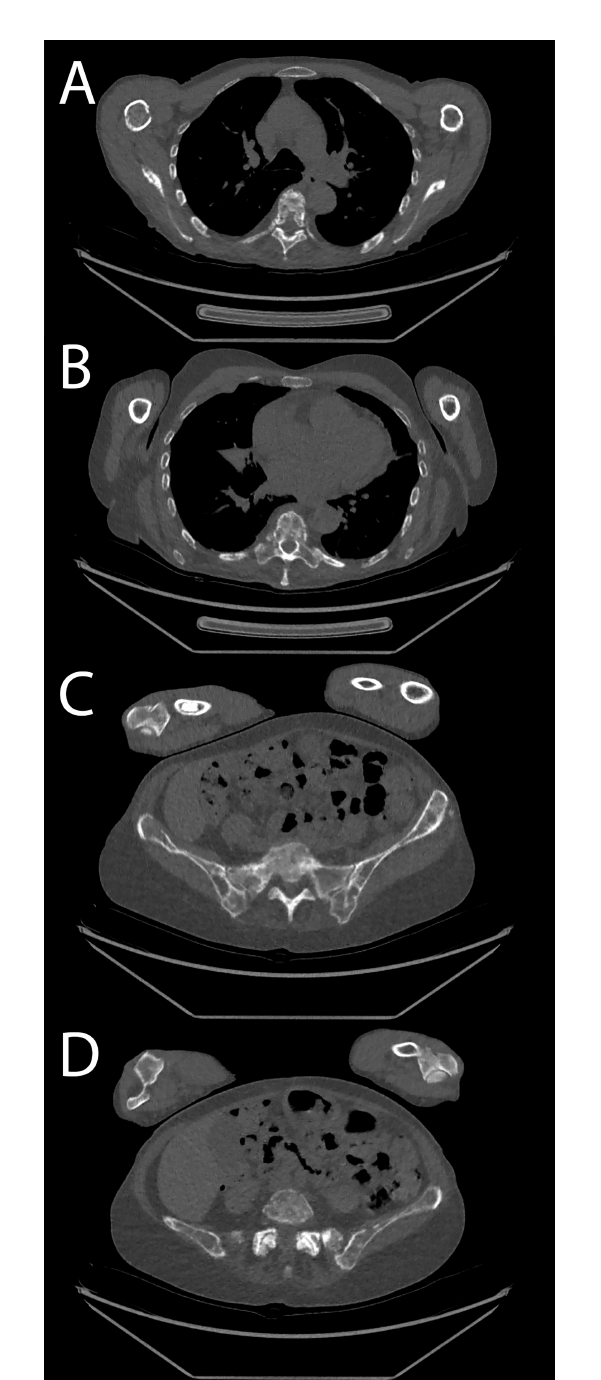
FIGURE 8 | Patient acquired with low-dose protocol. (A, B) Thoracic spine and costal osteolytic lesion. (C, D) Sacrum and hip bone